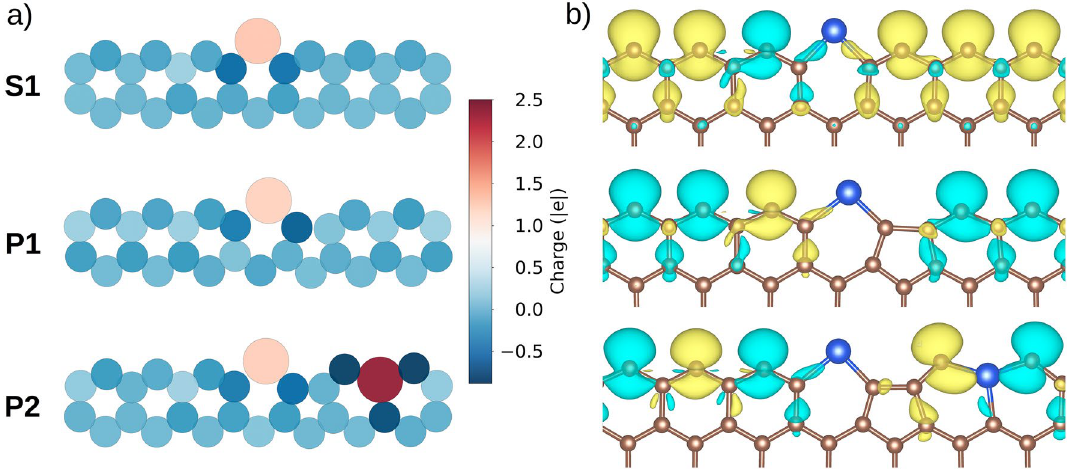
Figure 2. ( a ) Bader charges and ( b ) spin density on the top edge of selected S1 , P1 and P2 ground state structures. The values for yellow (α-spin) and blue (β-spin) isosurfaces are 0.005 e/ Å 3 . Carbon, and silicon atoms are depicted in brown and blue,